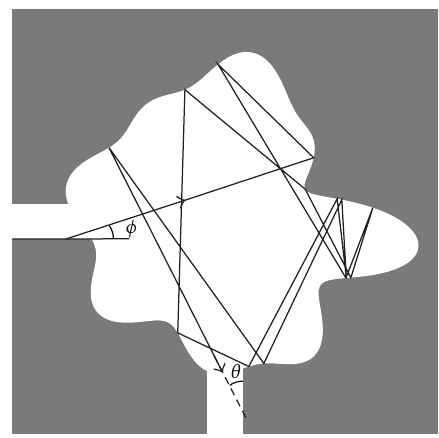
Figure 3: A sample trajectory from the emitter to the collector.